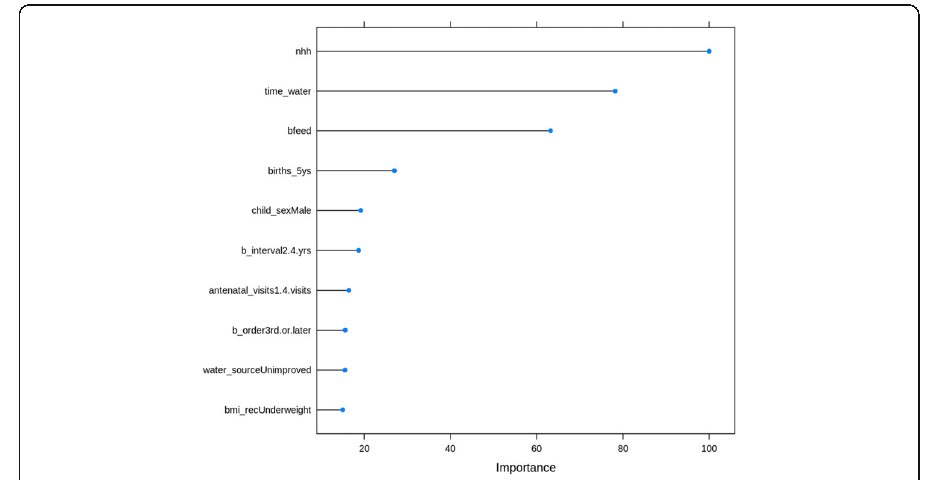
Fig. 3 Variable importance measures for the random Forest